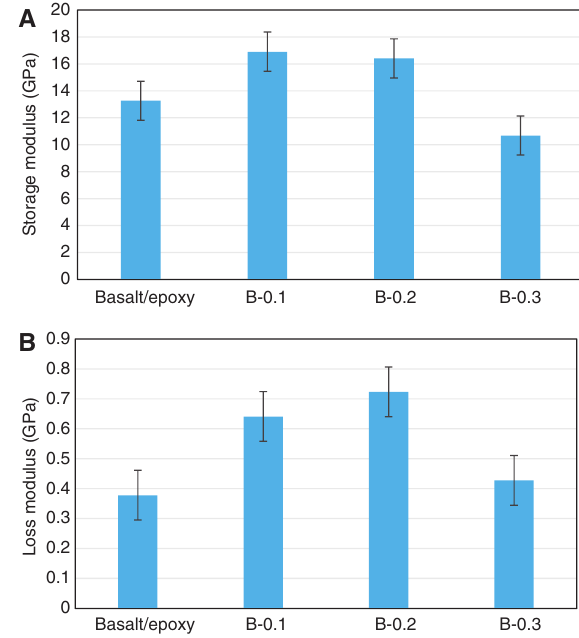
Figure 6: The dynamic mechanical properties of the test samples at different GnPs